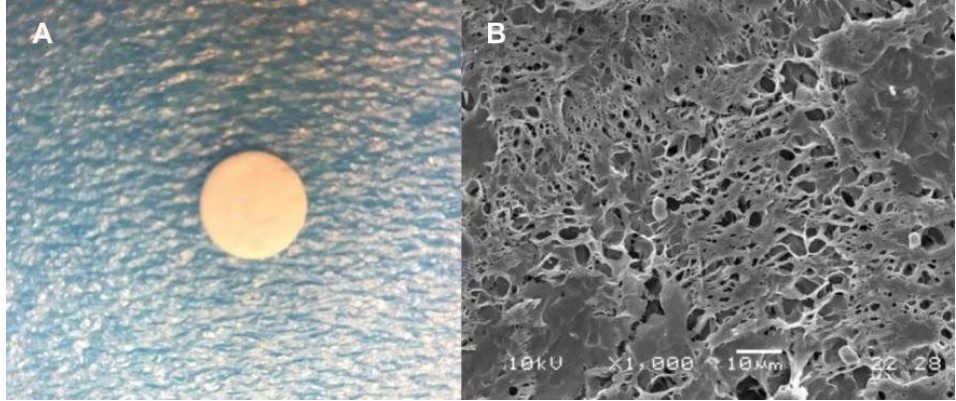
Figure 1. Morphological characterization, ( A ) Optical image of ZEOP 1% disc 10 mm, ( B ) SEM micrograph of ZEOP 1% (1000×).